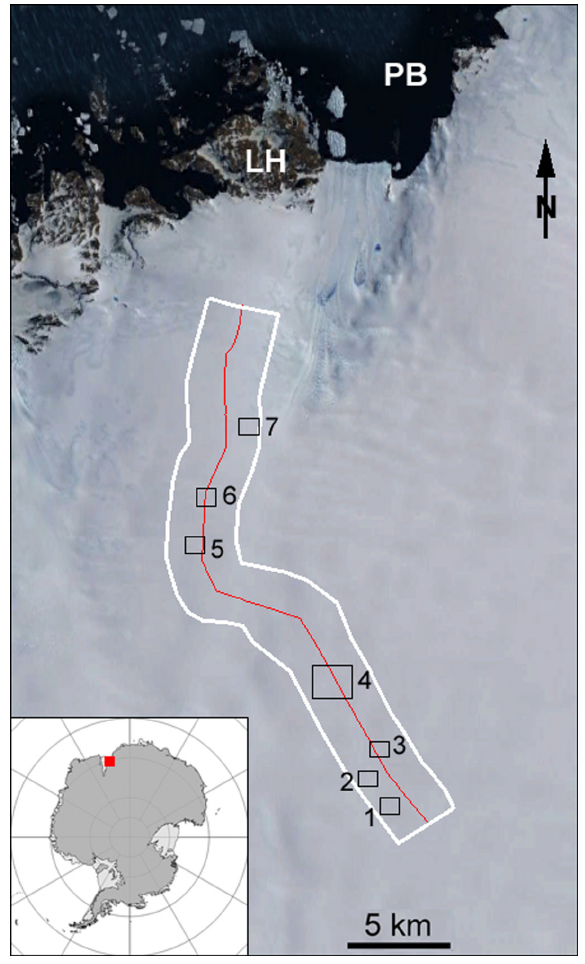
Figure 1. Geographical location of the surveyed area on the background of the U.S. Geological Survey image mosaic (from the Google Earth). The white frame — the area of the initial section of the sledge route (the red line) from the Progress to Vostok Stations. Black frames 1–7 — sites for studying microtopographic snow/ice features of eolian origin (see Figs. 4–8). LH — Larsemann Hills; PB — Prydz Bay